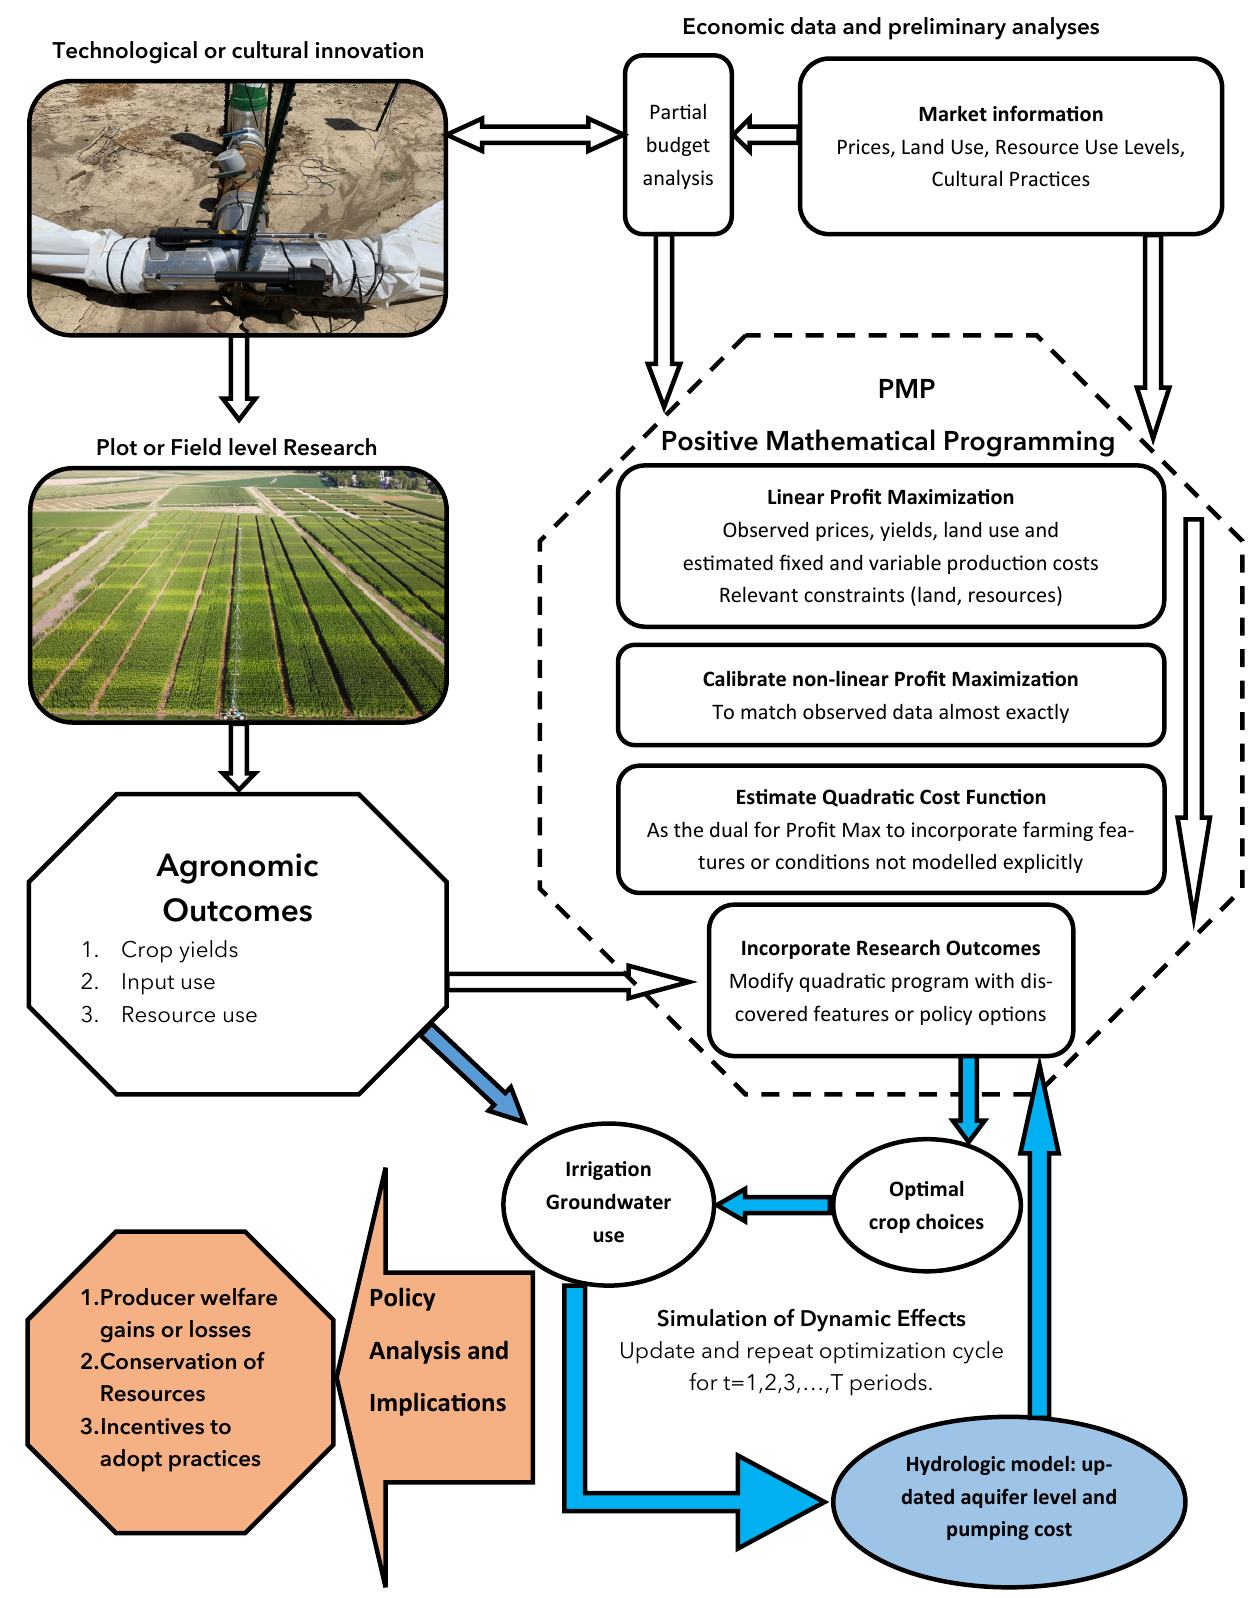
Figure 3. A diagram depicting multidisciplinary research using positive mathematical programming (PMP) to integrate plot-level research into basin-wide models and drawing policy